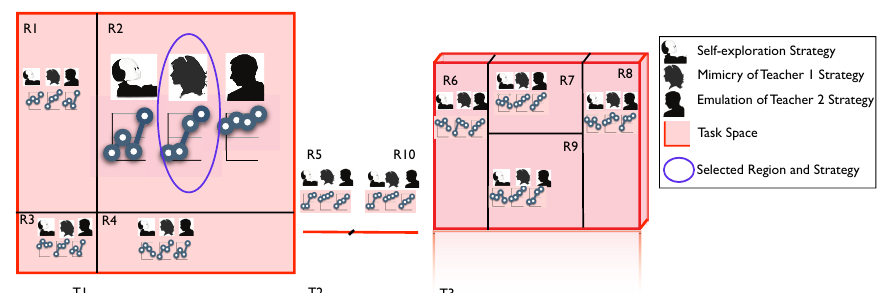
Figure 4. The selection of outcome and strategy is based on a partition of the outcome space with respect to di(cid:636)erent competence progress levels. We illustrate with the case of an outcome space of 3 di(cid:636)erent types of outcomes. measures of